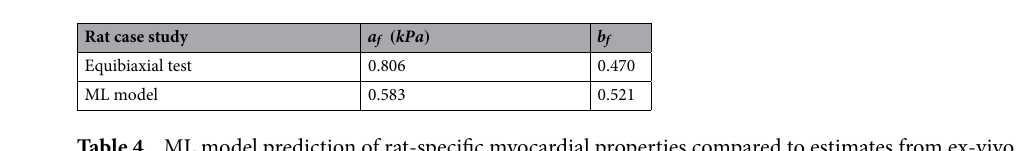
Table 4. ML model prediction of rat-specific myocardial properties compared to estimates from ex-vivo equibiaxial testing of the LVFW myocardium specimen for the same